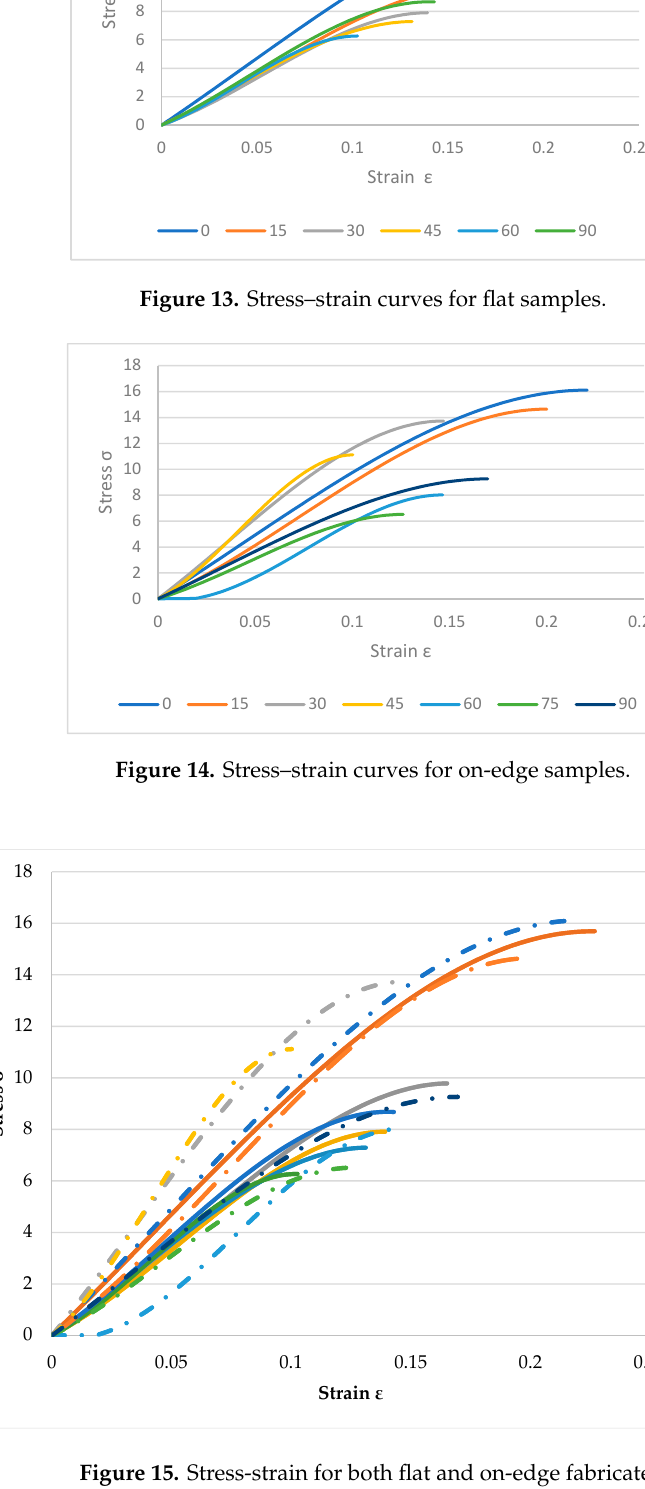
Figure 15. Stress-strain for both flat and on-edge fabricates.